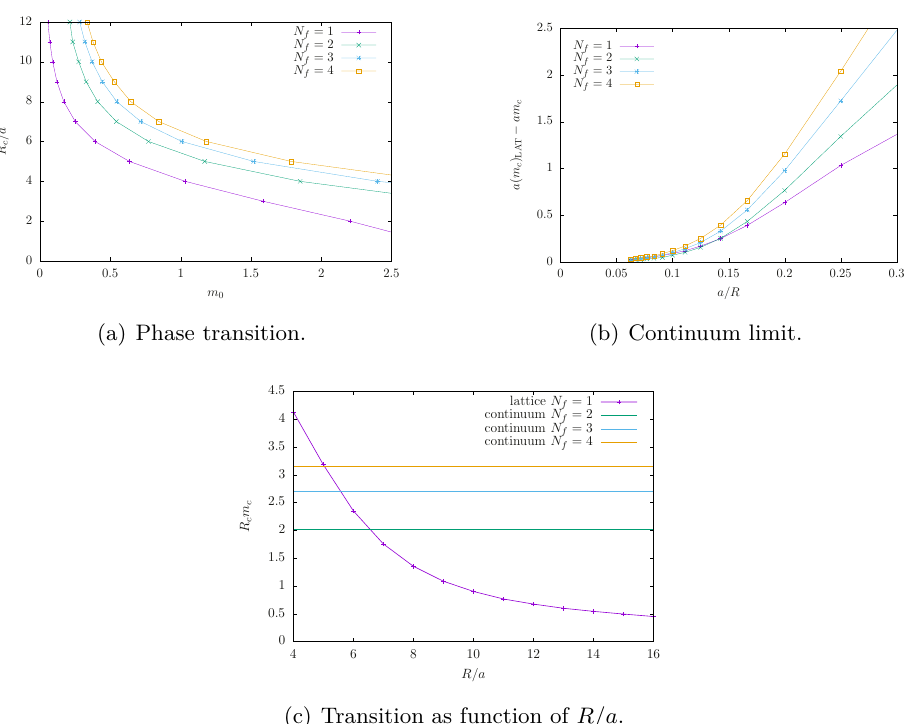
Figure 3 . Figure (a): numerical determination of the critical radius R c for the deconfinement transition as a function of the mass in the one-loop approximation on the lattice from eq. (4.14) for N f QCD(adj). In figure (b) the deviations of the critical mass ( m c ) LAT determined by the one-loop lattice effective potential from the expected continuum result m c (eq. (5.4)) are represented as a function of a/R . Keeping R fixed, the difference tends to zero in the continuum limit. Figure (c) represents the transition for N f = 1 as a function of R/a to compare R c m c with the values of eq.